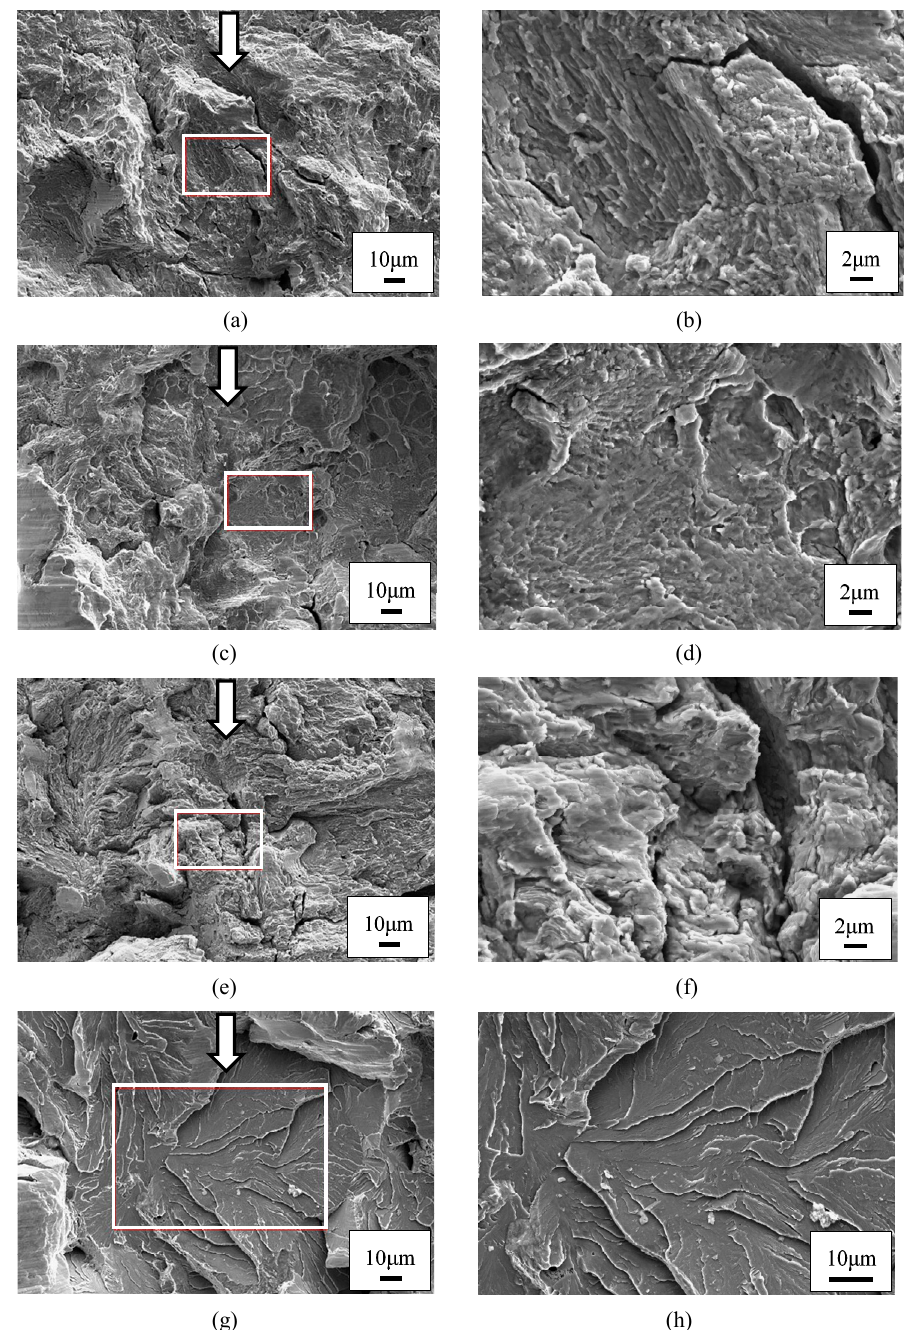
Figure 14. Fracture surface of RP2 observed via SEM (arrows indicate the direction of the crack growth). ( a ) 2 mm from the notch tip, ( b ) an enlarged view indicated by the frame in ( a ), ( c ) 4 mm from the notch tip, ( d ) frame in ( c ), ( e ) 6.8 mm from the notch tip, ( f ) frame in ( e ), ( g ) 8 mm from the notch tip, and ( h ) frame in ( g ).